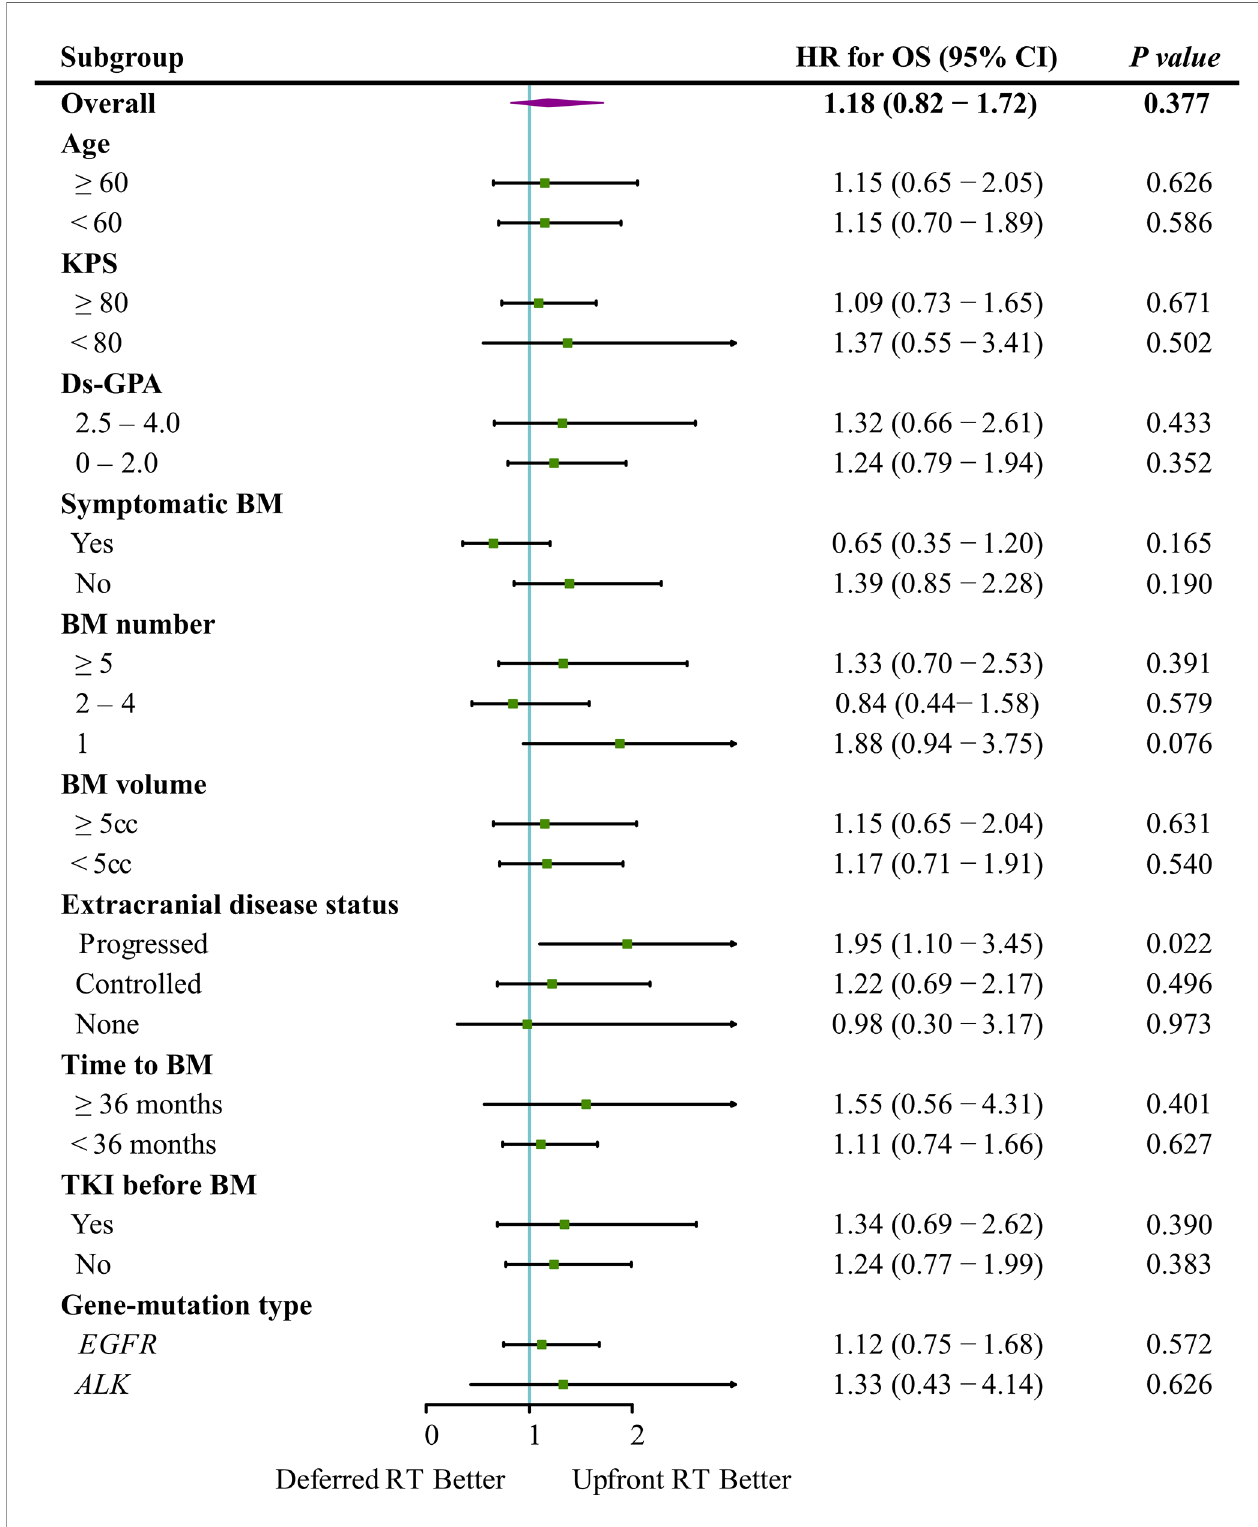
FIGURE 3 | Forest plot depicting the HRs of deferred RT vs. upfront RT regimens in different subgroups.